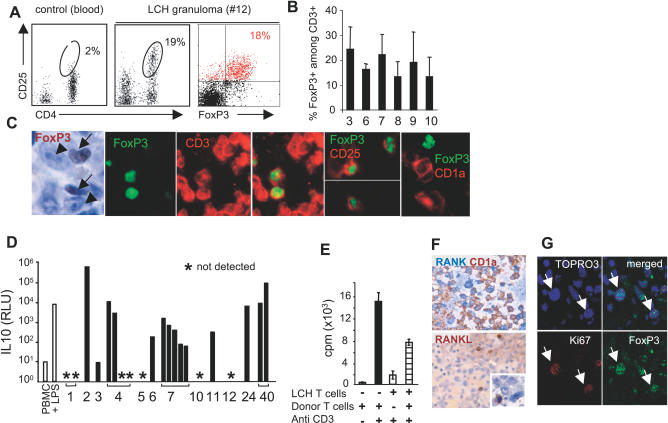
CD4+ CD25+ FoxP3high T Cells Accumulate in LCH Granulomas(A) Identification of CD4+ CD25+ FoxP3+ T cells by flow cytometry on fresh granuloma tissue. Dot plots are representative of similar data obtained in three patients (11, 12, and 29).(B) Histograms represent percentage of FoxP3+ T cells among CD3+ T cells in eosinophilic granuloma: 17.2% ± 3.36% of T lymphocytes expressed FoxP3 (n = 6).(C) Left image, immunohistochemical staining on a paraffin-embedded section with FoxP3 antibodies showing FoxP3+ T cell (arrow, brown nucleus) in close contact with histiocytes (arrowhead). Right images, double immunofluorescence labelling with anti-FoxP3 (green nucleus) and anti-CD3+, anti-CD25+, or anti-CD1a (red) in frozen sections.(D) Real-time PCR assay showing a high level of IL10 transcripts in eosinophilic granulomas (n = 12 patients).(E) T cells were isolated by CD3+ selection from a fresh LCH biopsy (patient 12; LCH T cells) and from the peripheral blood of a healthy blood donor (Donor T cells) and were stimulated by soluble OKT3 (Anti-CD3) in the presence of CD14+ monocytes. Unsorted T cells from an LCH granuloma (LCH T cells) caused an approximate 50% decrease in the proliferation of normal T cells. Filled bar, healthy donor T cells alone, open bar LCH T cells alone, hatched bar, mix of healthy donor T cells and LCH T cells.(F) Immunohistochemistry on paraffin-embedded section from an eosinophilic granuloma using RANK (upper) and RANKL antibodies (bottom) (n = 9 patients).(G) Double immunolabeling with Ki-67 and FoxP3 antibodies of frozen sections from an eosinophilic granuloma (n = 2 patients).